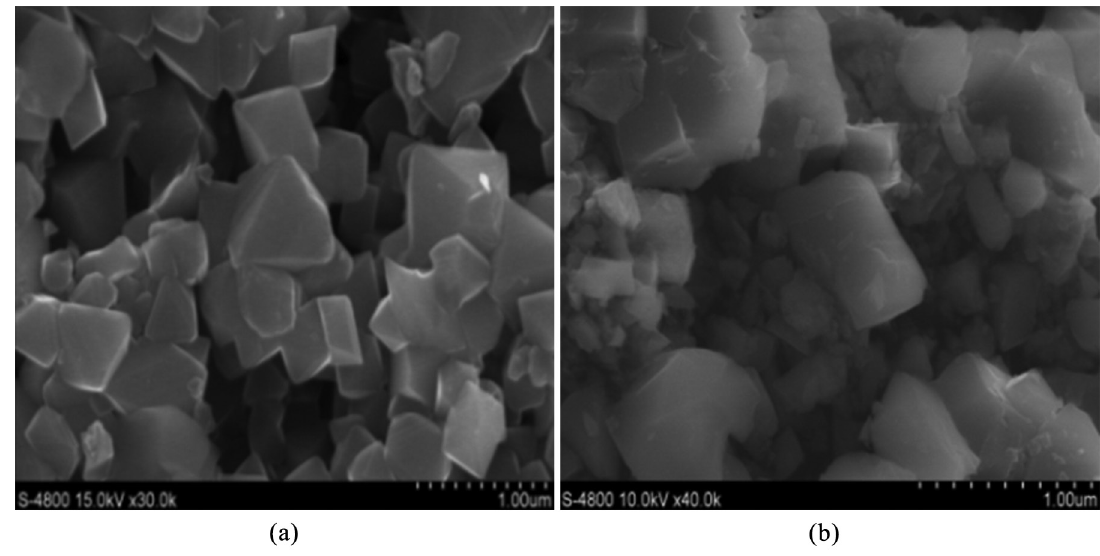
Figure 5. SEM images of LMO particles (a) and LNMO particles (b).